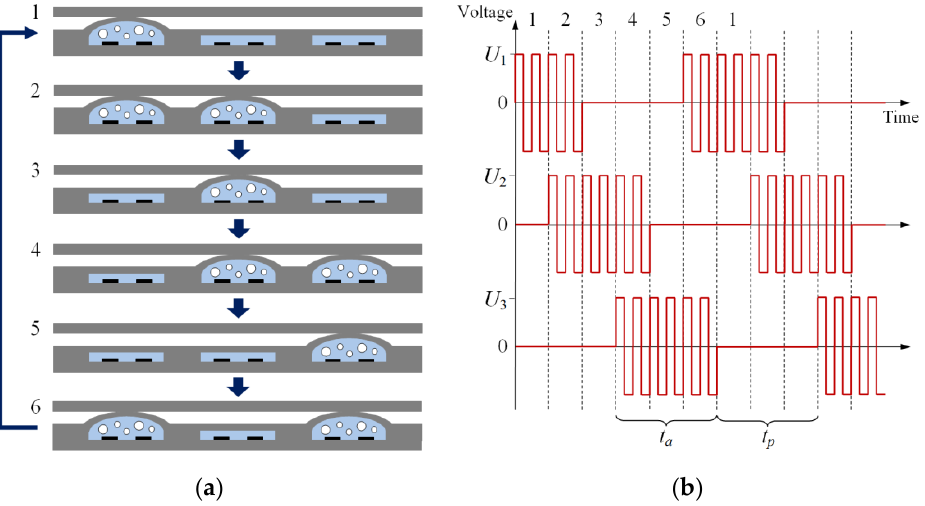
Figure 3. Working principle of the micropump. The image ( a ) illustrates sequential operation of the actuators. The liquid is pushed from left to right. The driving signals are schematically illustrated in panel ( b ). The AP voltage pulses are applied to each actuator during the active time t a . The numbers at the top indicate the pumping phases.